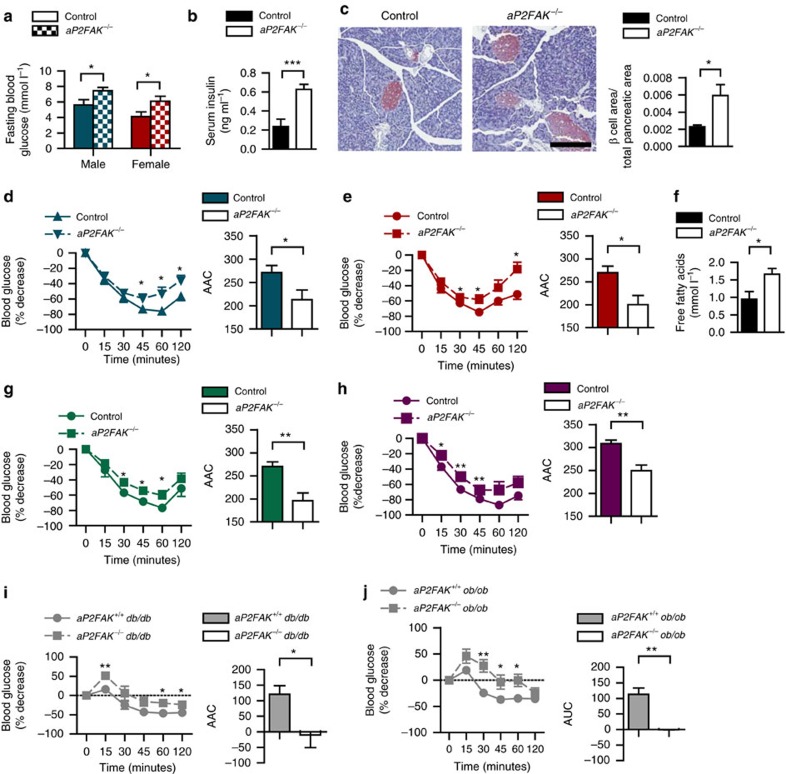
Adipocyte FAK is required for maintenance of glucose homeostasis.(a) Fasting blood glucose in male (n=9) (blue) and female (n=10) (red) control or aP2FAK−/− mice at 12 weeks of age. Fasting serum insulin (n=10) (b) and pancreas sections from 20- to 24-week-old mice stained by IHC for insulin (red; scale bar, 200 μm) with quantification (n=5 mice) (c). ITT and area above the curve (AAC) in male (n=12) (d) and female (n=10) (e) 20- to 24-week-old mice. (f) Fasting serum free fatty acid levels in 20- to 24-week-old mice (n=6). ITT and AUC in male (n=10) (g) and female (n=9) (h) 20- to 24-week-old mice fed HFD for 12–16 weeks or 6- to 8-week-old mice on db/db (n=6) (i) or ob/ob genetic background (n=9) (j). Data are mean±s.e.m. * P<0.05, **P<0.01 and ***P<0.001 by Student's t-test.